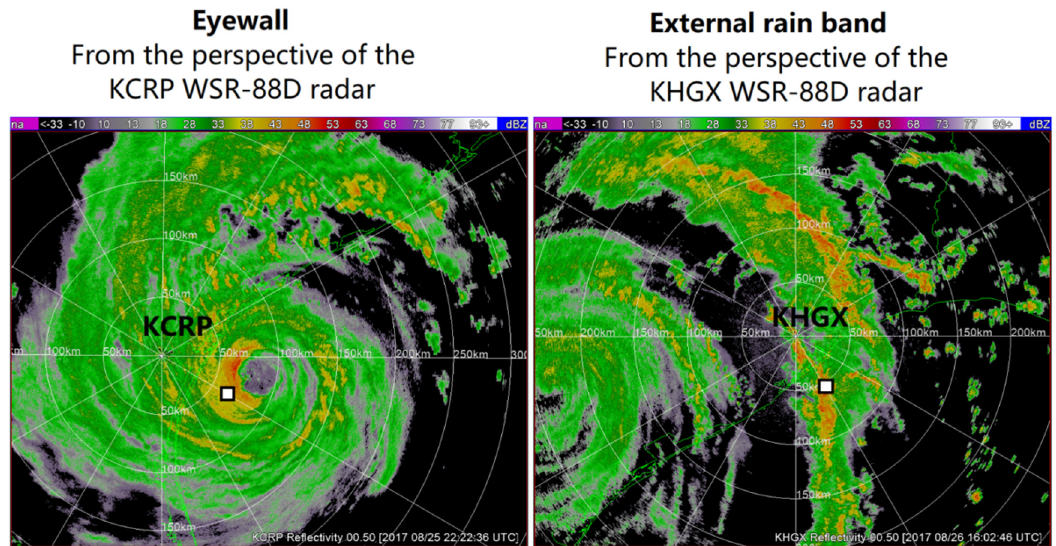
Figure 15. Plan position indicator (PPI) images of Z H at a 0.5° elevation angle. ( Left panel ) Harvey’s inner eyewall and ( right panel ) Harvey’s outer rain band. Radar columnar vertical profile (CVP) sectors are labeled by the white boxes. The thick blue line with black dots represents a track of Harvey’s eye.